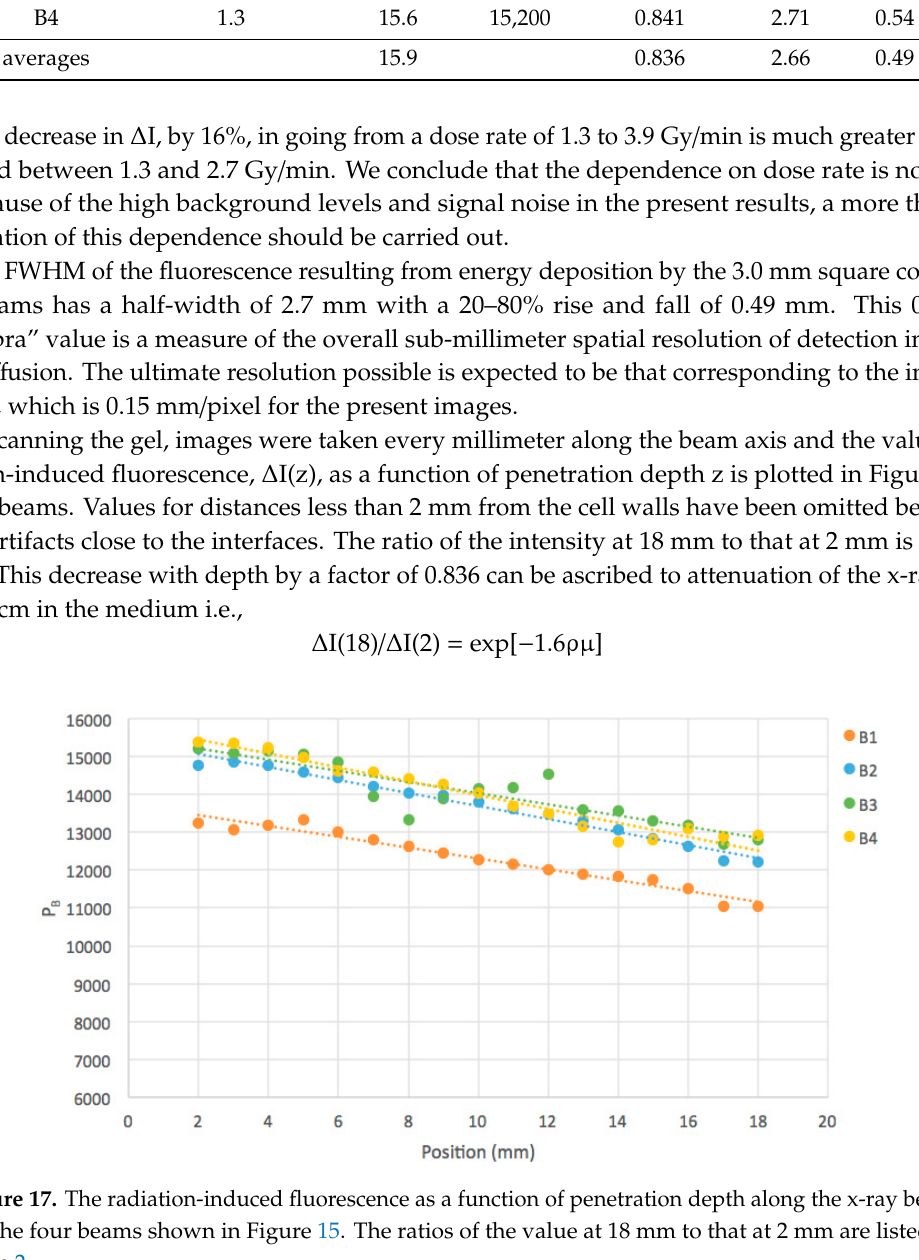
Table 2. The parameters derived from the pixel profile scans in Figure 16, the symbols are defined in the text.